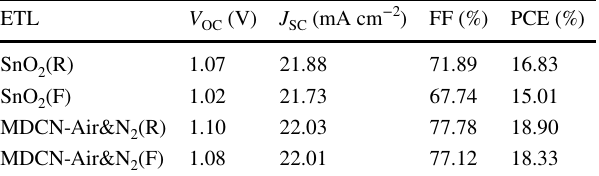
Table 4 Photovoltaic parameters of PSCs with SnO 2 and MDCN‑ Air&N 2 ETLs measured under reverse and forward voltage